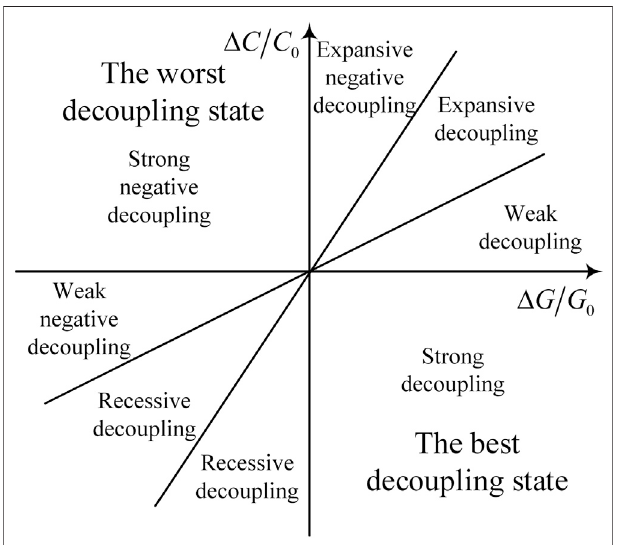
FIGURE 2 | Interpretation of phase-difference. Note: the arrow between the variables indicates the direction of causality.